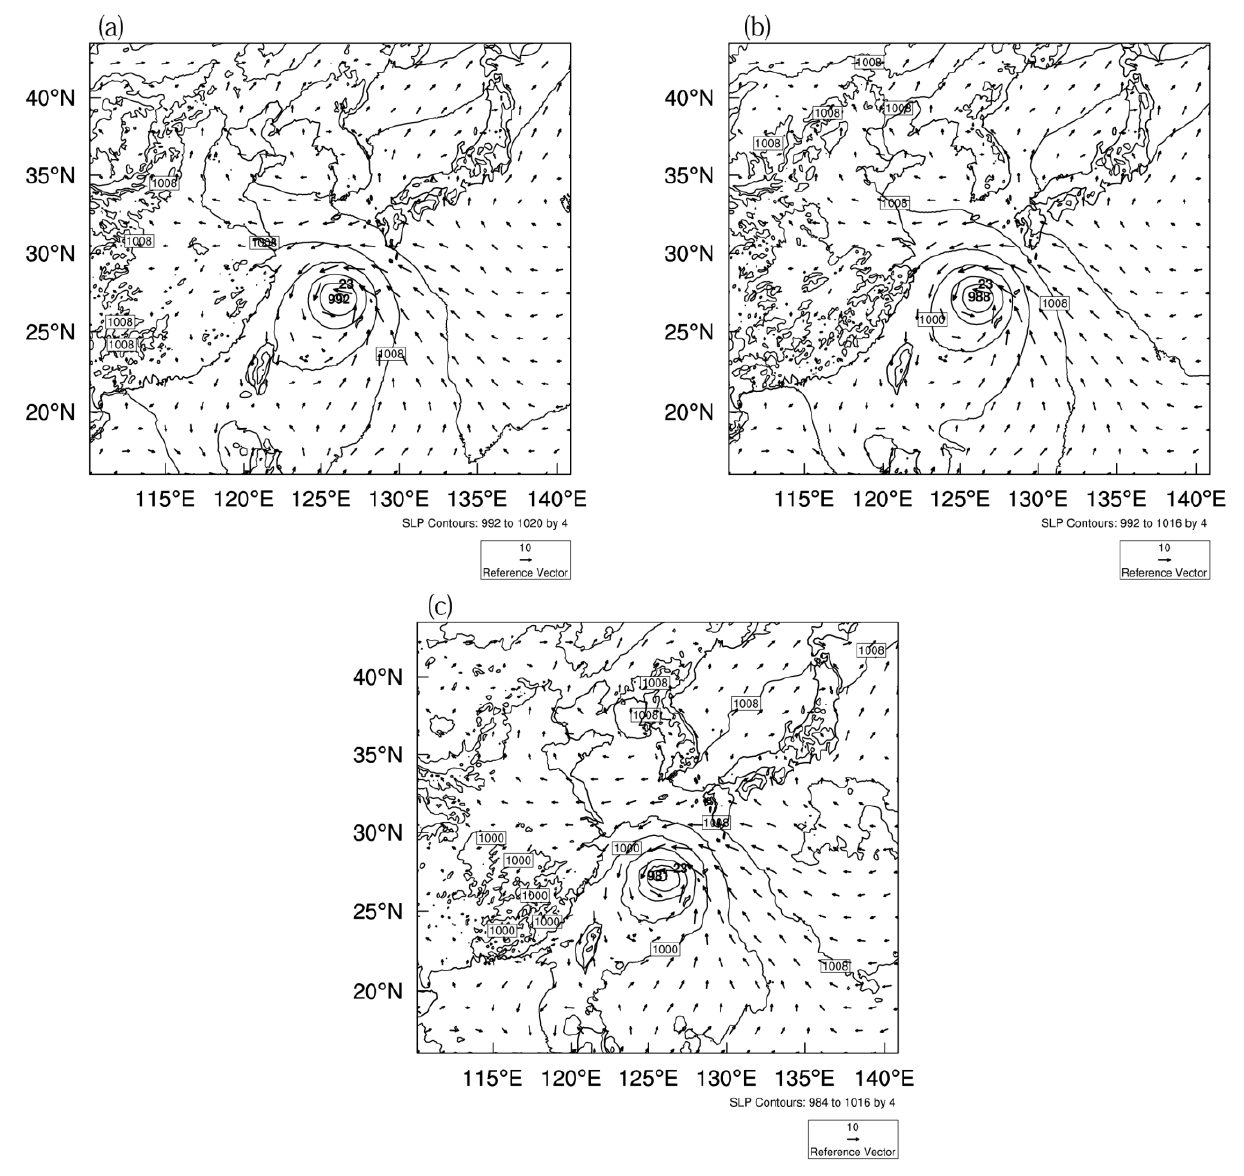
Figure 11. Sea level pressure (contours, unit: hPa) and surface wind field (vectors, unit: m/s) of ( a ) the CONV experiment, ( b ) the 3DVar experiment, and ( c ) the EnVar experiment at 0600 UTC on 21 July 2018.